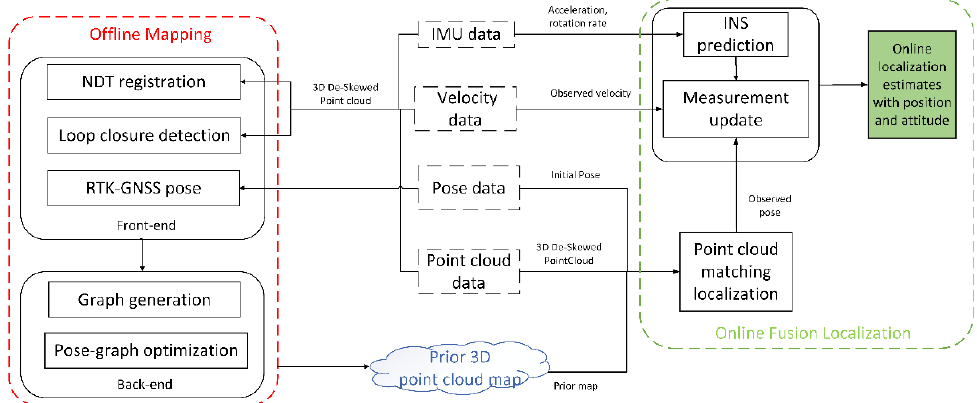
Figure 1. The framework that estimates the optimal position and attitude (PA) for the autonomous vehicle by combining offline mapping and online localization. NDT: normal distributions transform, RTK-GNSS: real time kinematic-global navigation satellite system, IMU: inertial measurement unit, INS: inertial navigation system